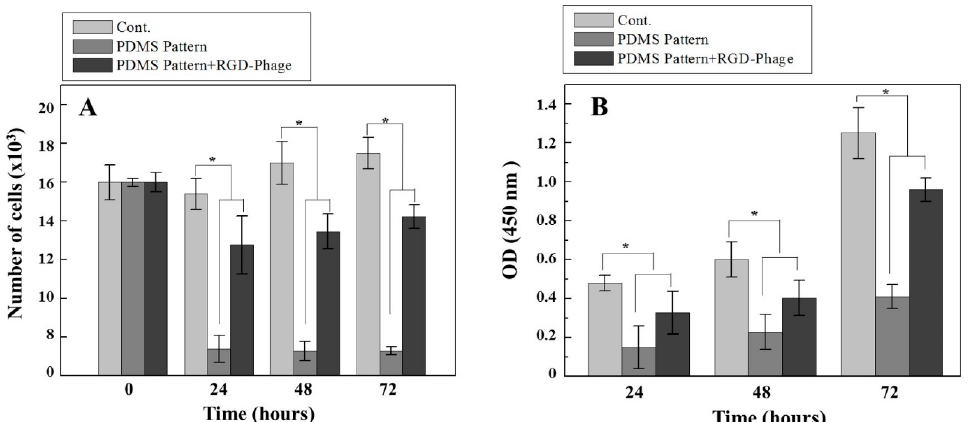
Figure 4. Cell proliferation rate as determined by cell counts ( A ) and CCK-8 assay ( B ). Cell number was determined using Image J (The number of cells per unit cm 2 ). Data were analyzed statistically by ANOVA at a p < 0.05 confidence interval and Fisher’s LSD test. Asterisk denotes differences of the populations (* p < 0.05 compared to respective controls).